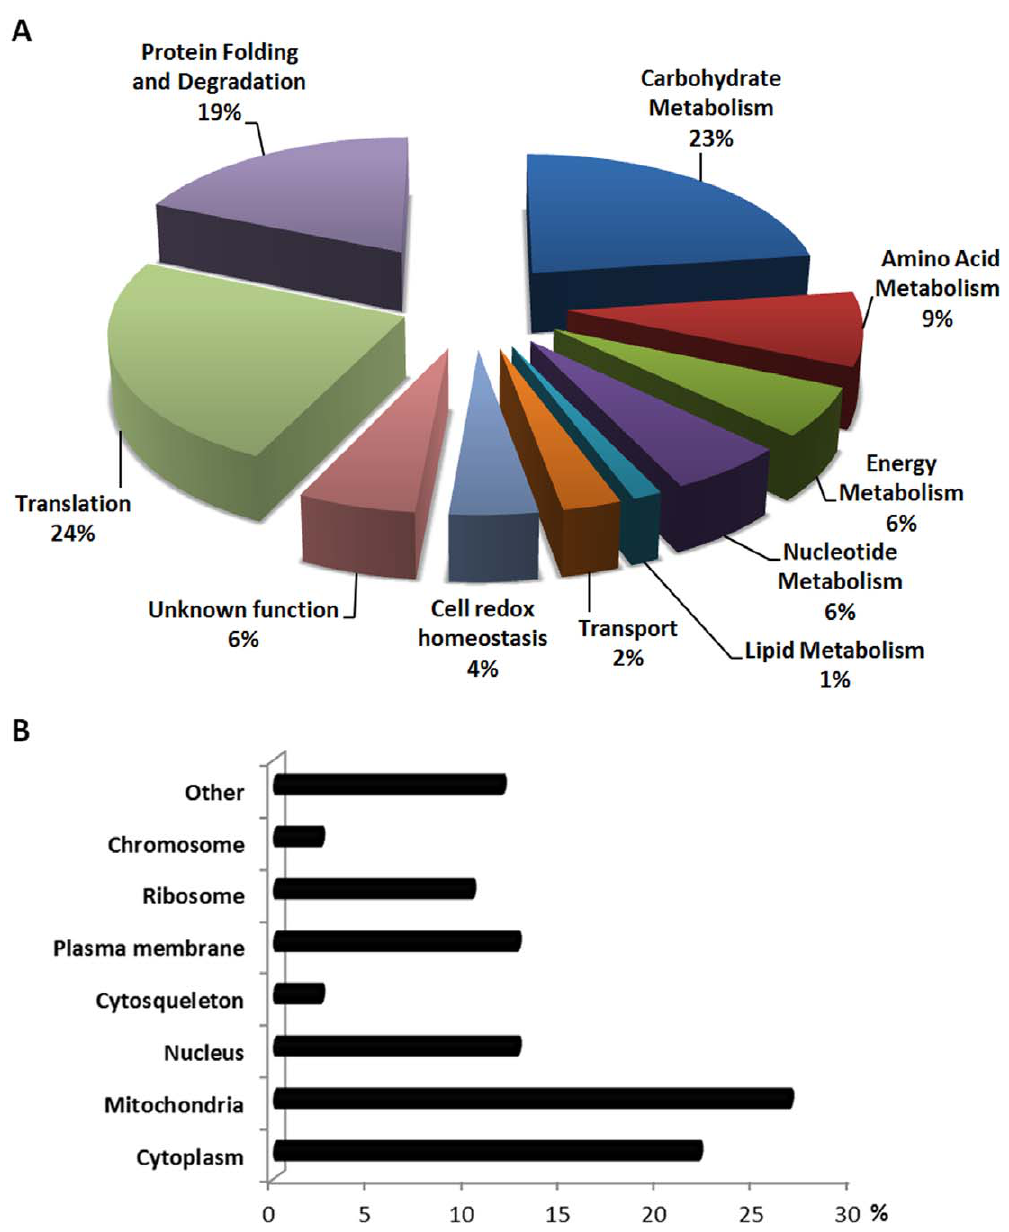
Figure 3. Gene ontology characterization of the identified differentially expressed proteins. (A) Biological function. (B) Cellular location.